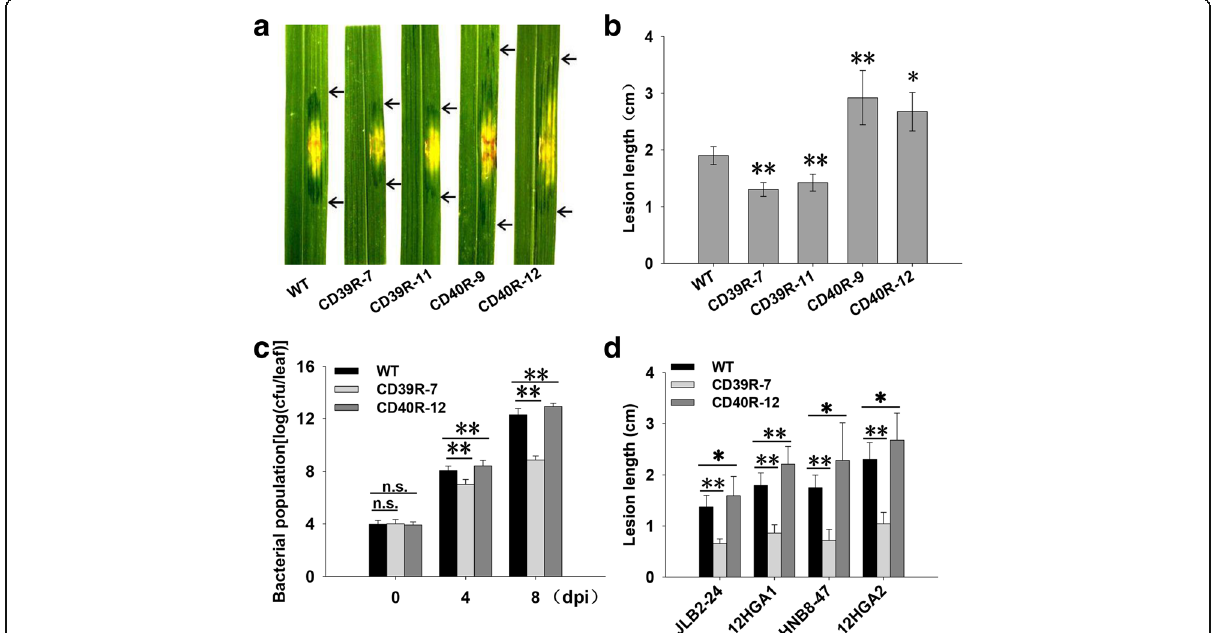
Fig. 4 Resistance performance of transgenic plants at the T 2 generation. a Representative lesion site from plants at 14 dpi with Xoc strain RS105. b Lesion length scored for the T 2 transgenic plants of pU1301:: OsHsp18.0-CI (CD39R-7 and CD39R-11) and ds1301:: OsHsp18.0-CI (CD40R-9 and CD40R-12) at 14 dpi. The average lesion length for T 2 plants was measured in 10 to 12 individuals at more than 5 inoculation sites at 14 dpi. The bars represent the means±SD. c Bacterial population growth in leaves of CD39R-7, CD40R-12 and WT inoculated with RS105. Colonies were counted with the leaf segment up to 5 cm from the inoculation site. Error bars represent standard deviation of three independent leaves. d Lesion length of CD39R-7, CD40R-12 and WT inoculated with JLB2-24, HNB8-47, HGA1 and